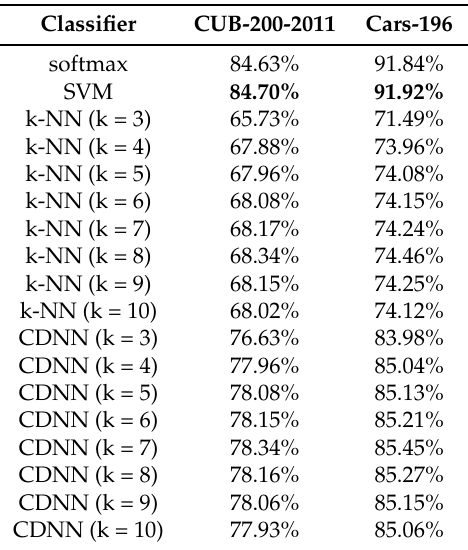
Table 3. Accuracy of different classifiers.